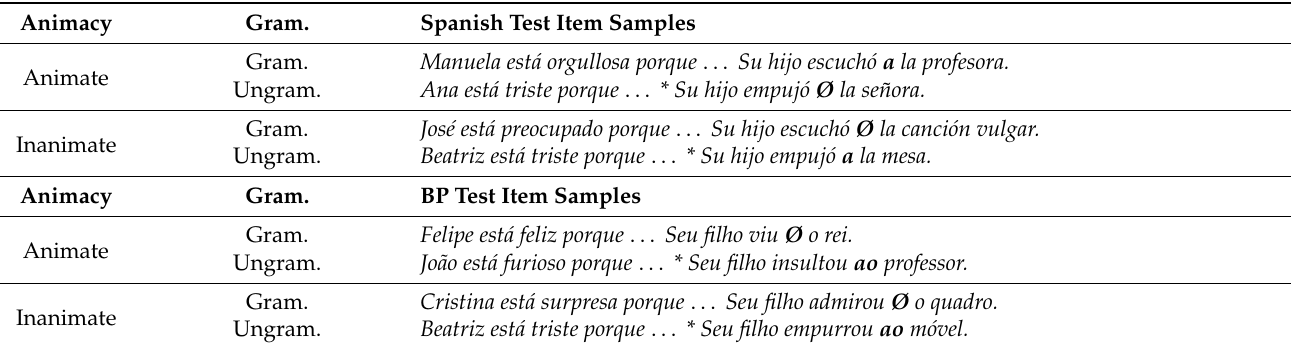
Table 4. Spanish and BP AJT item samples per